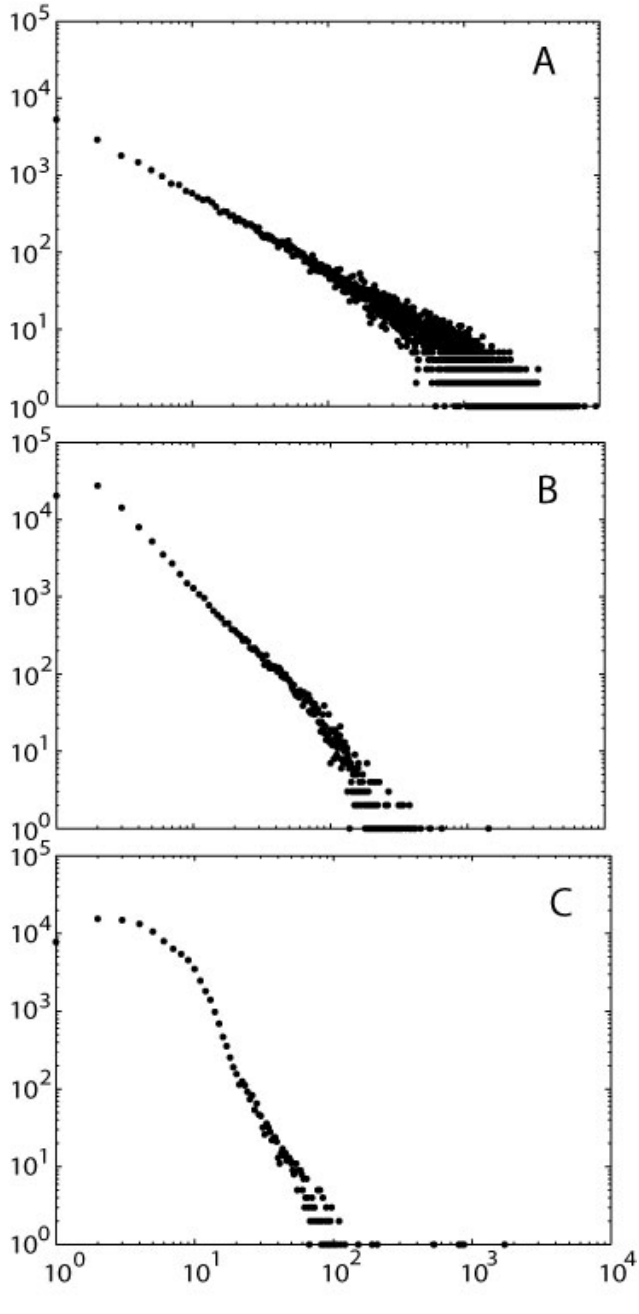
Fig. 3. These diagrams represent: A) the frequency distribution of the standard two-dimensional sandpile model1, for 100 000 iterations. B) the distribution of the change in the state variable for a uniform random walk for the two control parameters. C) the same process as in (B) but with the scale of observation set two orders of magnitude